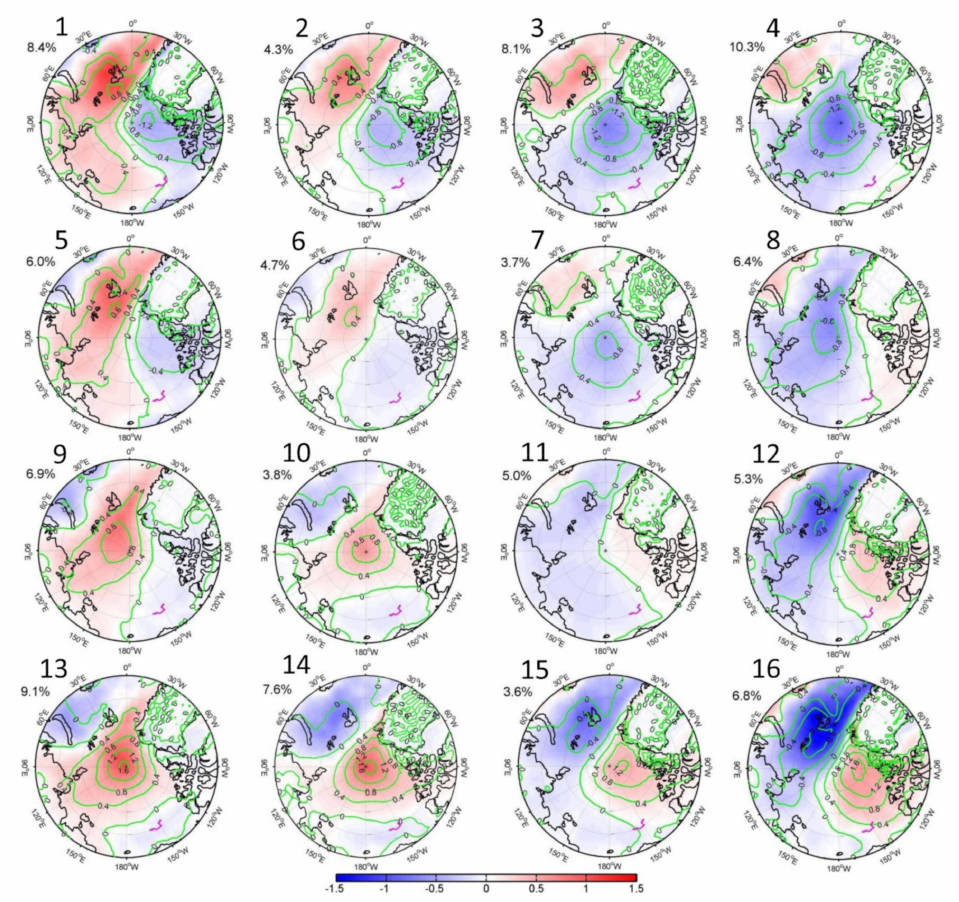
Figure 7. Temperature (units: ◦ C) (contour) and specific humidity inversion (units: 0.1 g kg − 1 ) inversion pattern from the self-organizing map (SOM) analysis of the wintertime 10–60-day filtered temperature and specific humidity di ff erence between 850 and 950 hPa at a 4 × 4 grid for the 1979–2017 period. The percentage at the top left of each panel indicates the frequency of occurrences of the pattern. The pink lines denote the track of the SHEBA campaign during January